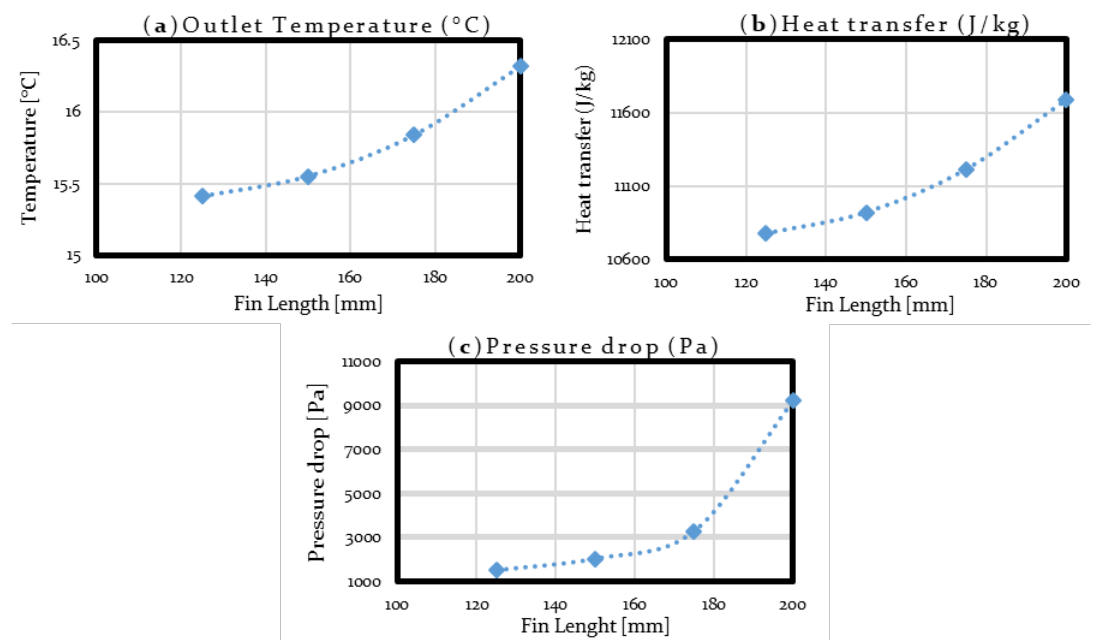
Figure 5. Ba ffl e length e ff ect on ( a ) Outlet temperature; ( b ) Heat transfer and ( c ) Pressure drop. Figure 5. Baffle length effect on ( a ) Outlet temperature; ( b ) Heat transfer and ( c ) Pressure drop.